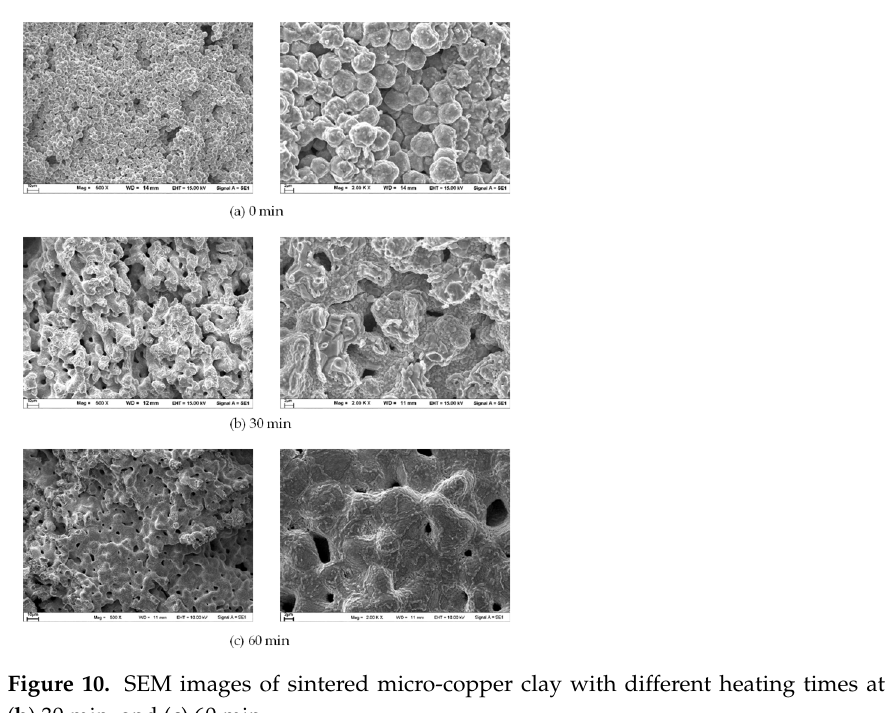
Figure 9. SEM images of sintered nano-copper clay with different heating times at ( a ) 0 min, ( b ) 30 min, and ( c ) 60 min.